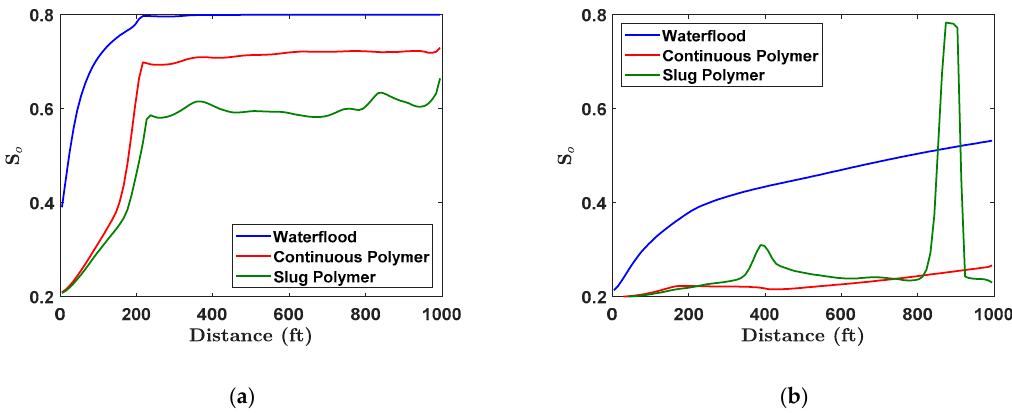
Figure 5. Oil saturation profiles for the test case in layer nine ( a ), and layer eight ( b ) at t D = 1.7.